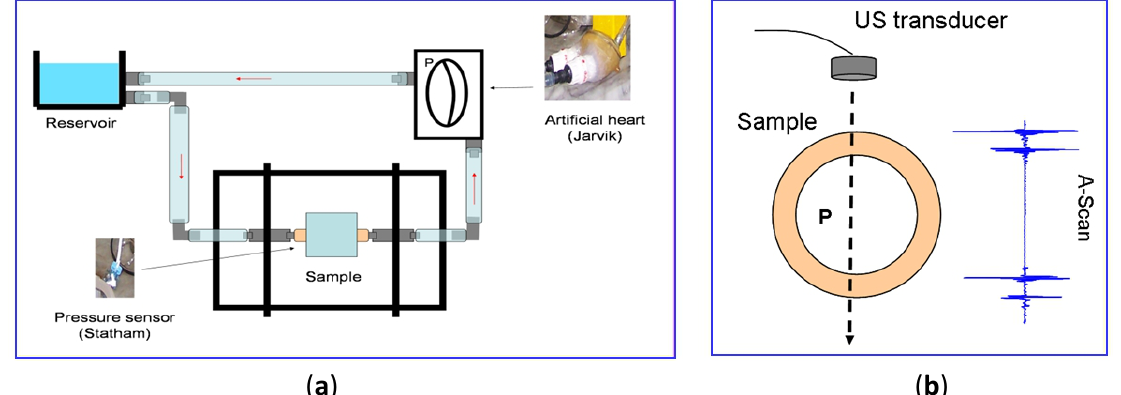
Figure 8. ( a ) Scheme of the experimental set-up for wall displacement measurements (circulating loop mimicking a physiological pulsatile flow inside the arterial phantom). ( b ) A-Scan containing four